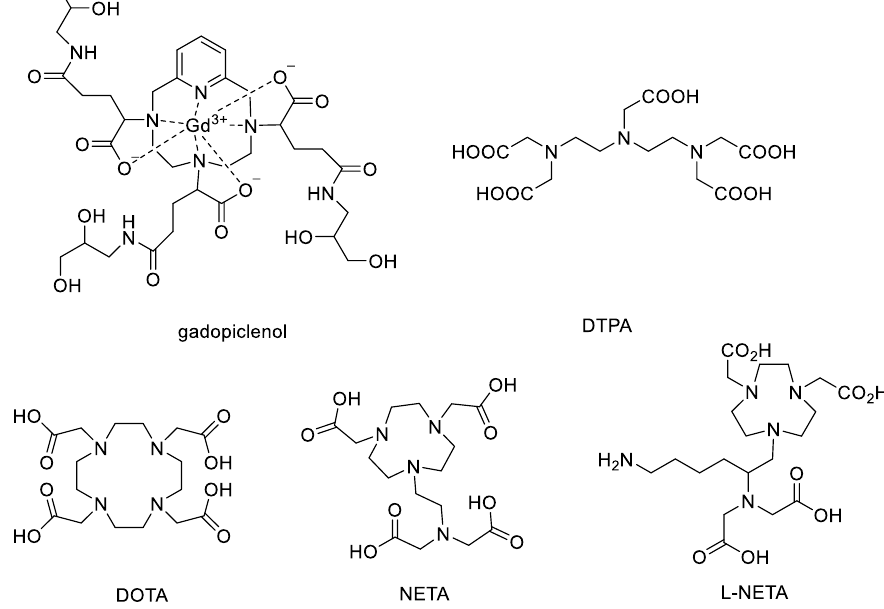
Figure 1. Structures of gadopiclenol and some gadolinium chelators for MRI